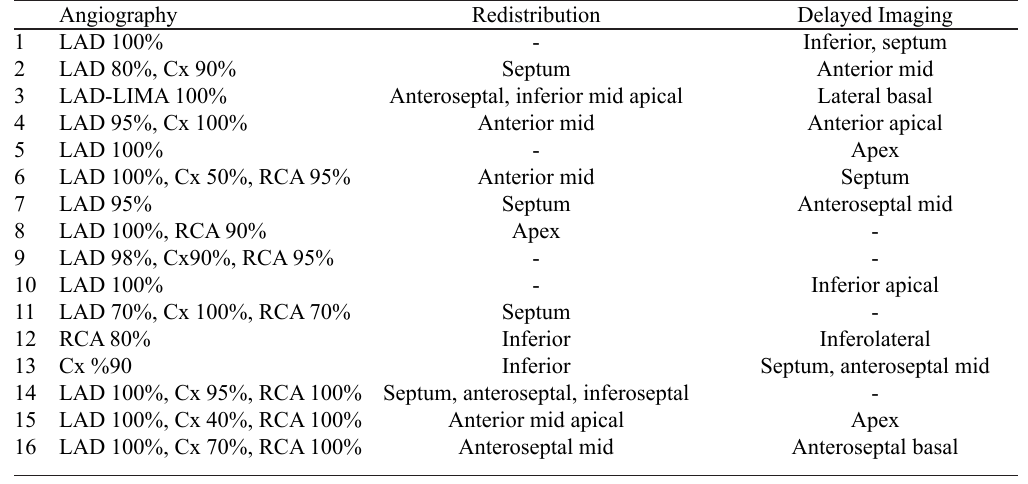
Table 2. Myocardial perfusion scintigraphy results of patients who have angiography